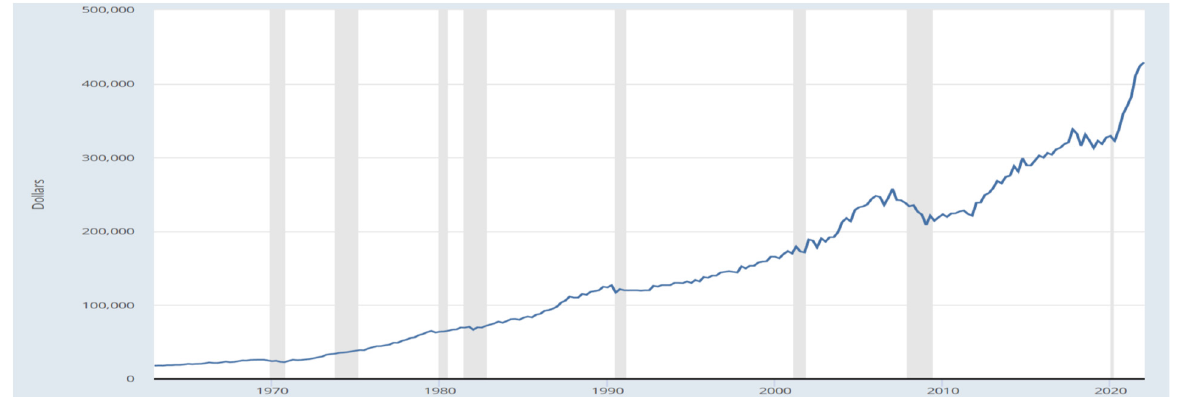
Figure 7. Median Sales Prices for New Homes Sold in US. Source: Census; HUD.